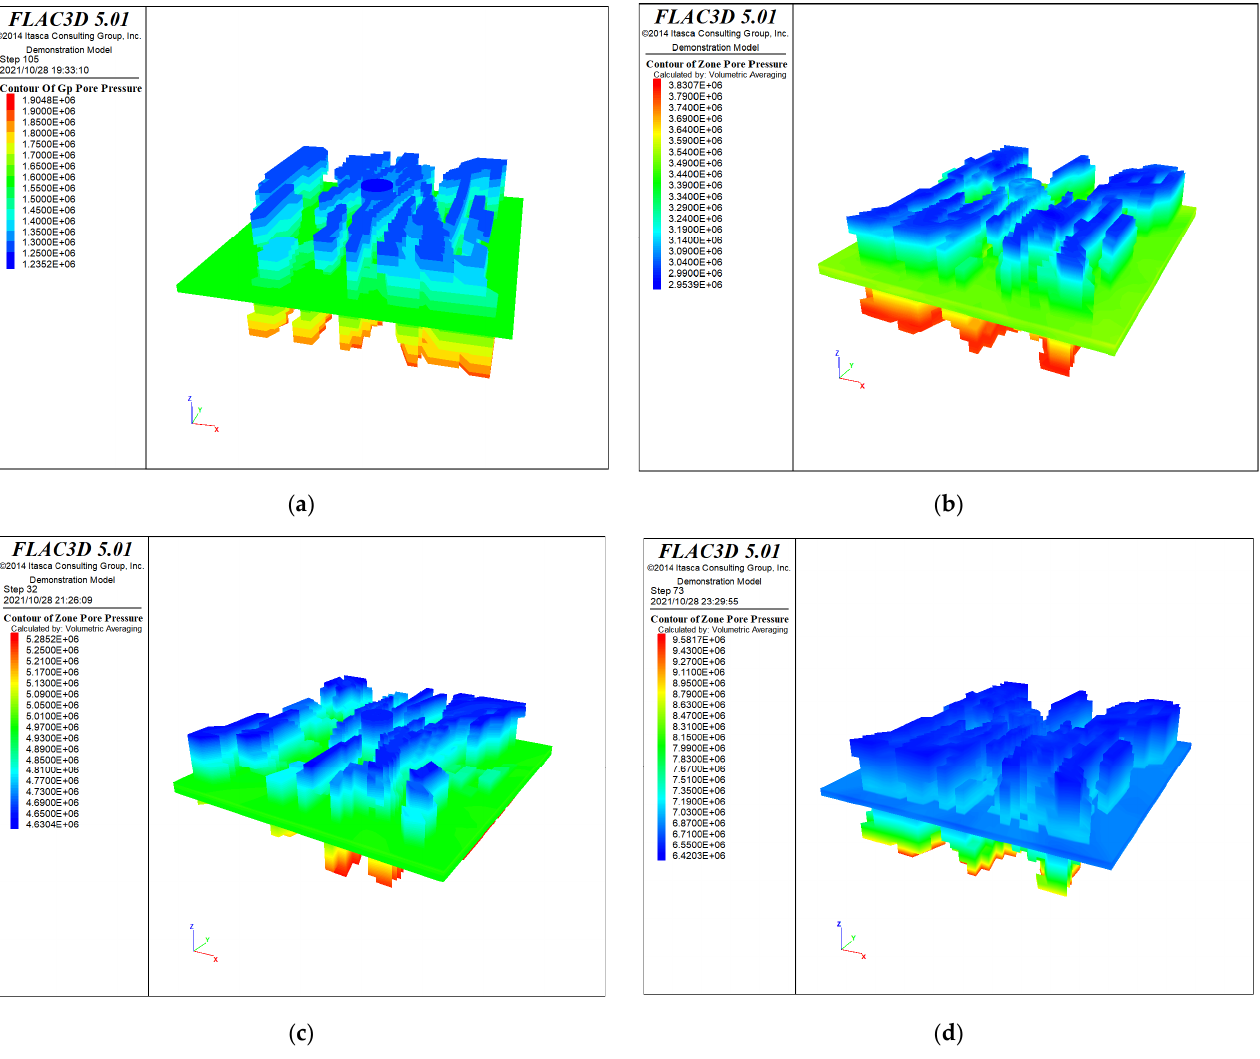
Figure 6. The initial pore pressure field of fracture network. ( a ) Aq1, ( b ) Aq2, ( c ) Aq3, ( d )